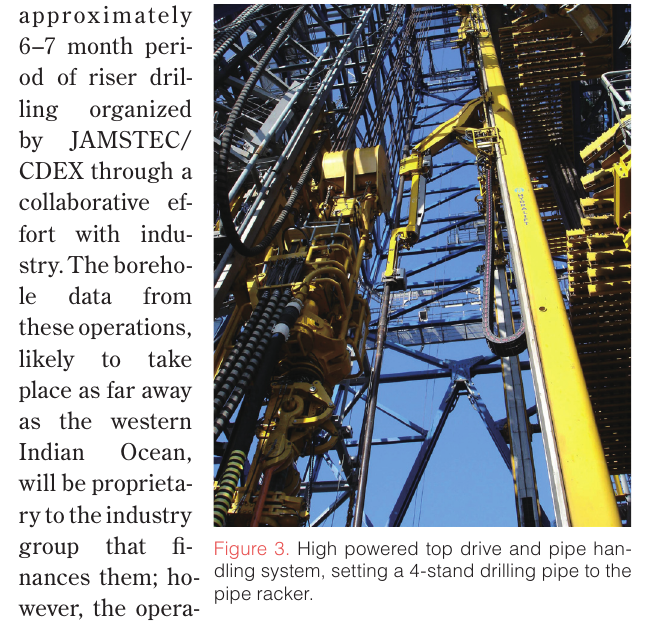
Figure 3. High powered top drive and pipe han- dling system, setting a 4-stand drilling pipe to the pipe